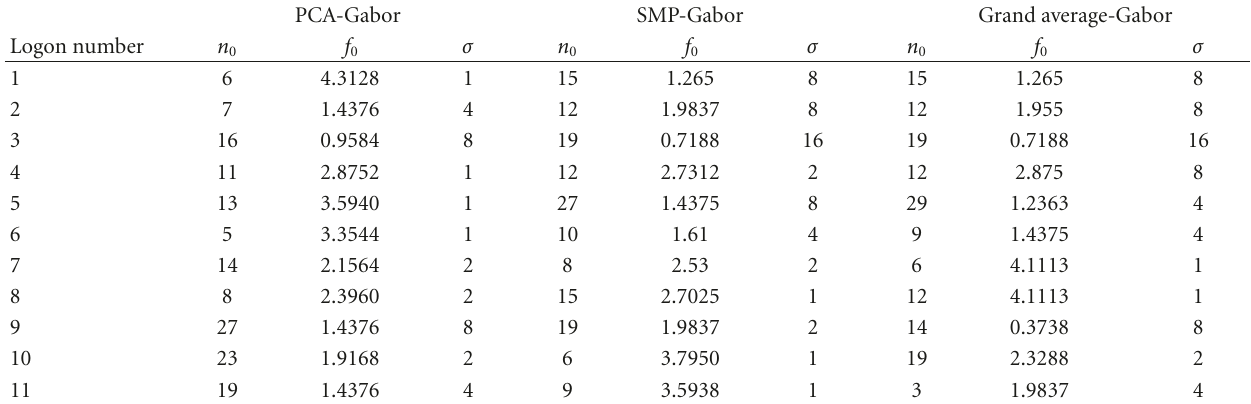
Table 4: The parameters (time center (samples), n 0 , frequency center (Hz), f 0 , and scale parameter σ ) of the 11 logons extracted by PCA- Gabor from the 11 PCs, SMP-Gabor from the 8238 TFD surfaces, and MP-Gabor from the grand average of the 8238 time-frequency surfaces. PCA-Gabor SMP-Gabor Grand